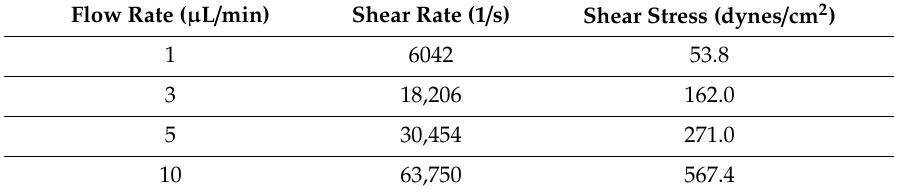
Table 2. Average shear rate and calculated shear stress on cells at each microtrap for the flow rates listed. Flow Rate ( µ L / min)